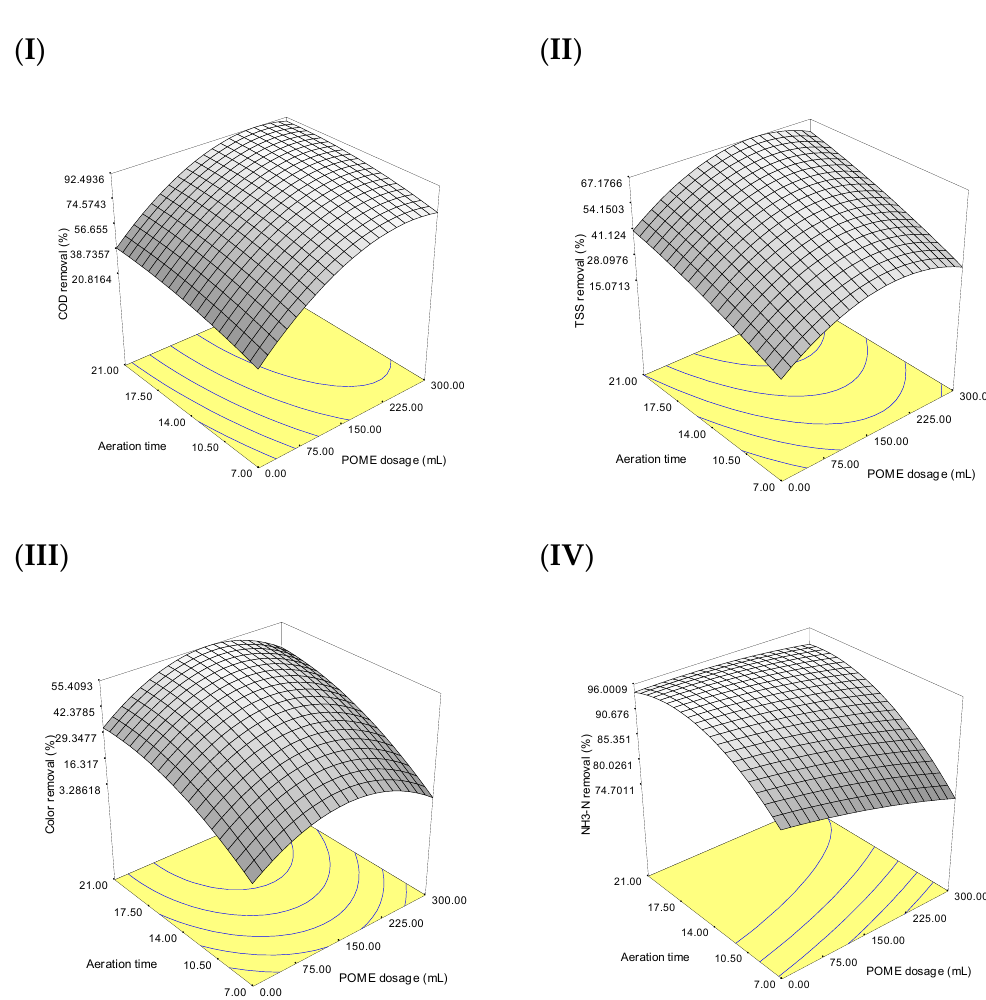
Figure 8. Response surface plot for ( I ) COD, ( II ) TSS, ( III ) color, and ( IV ) NH 3 -N removal.